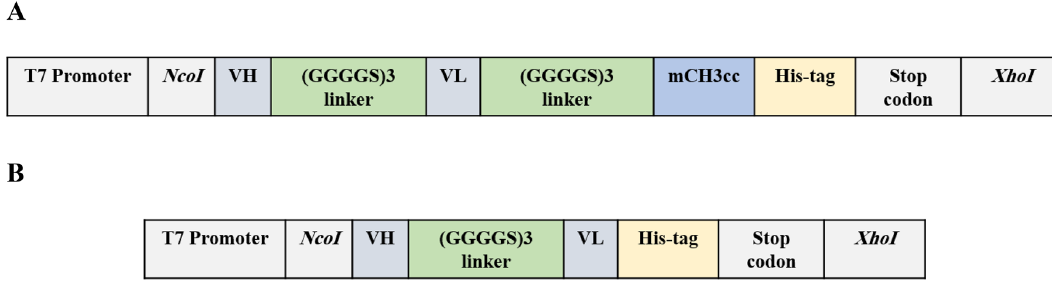
Figure 1. Schematic view of the expression cassettes: ( A ) YFL001; ( B ) YFL002.